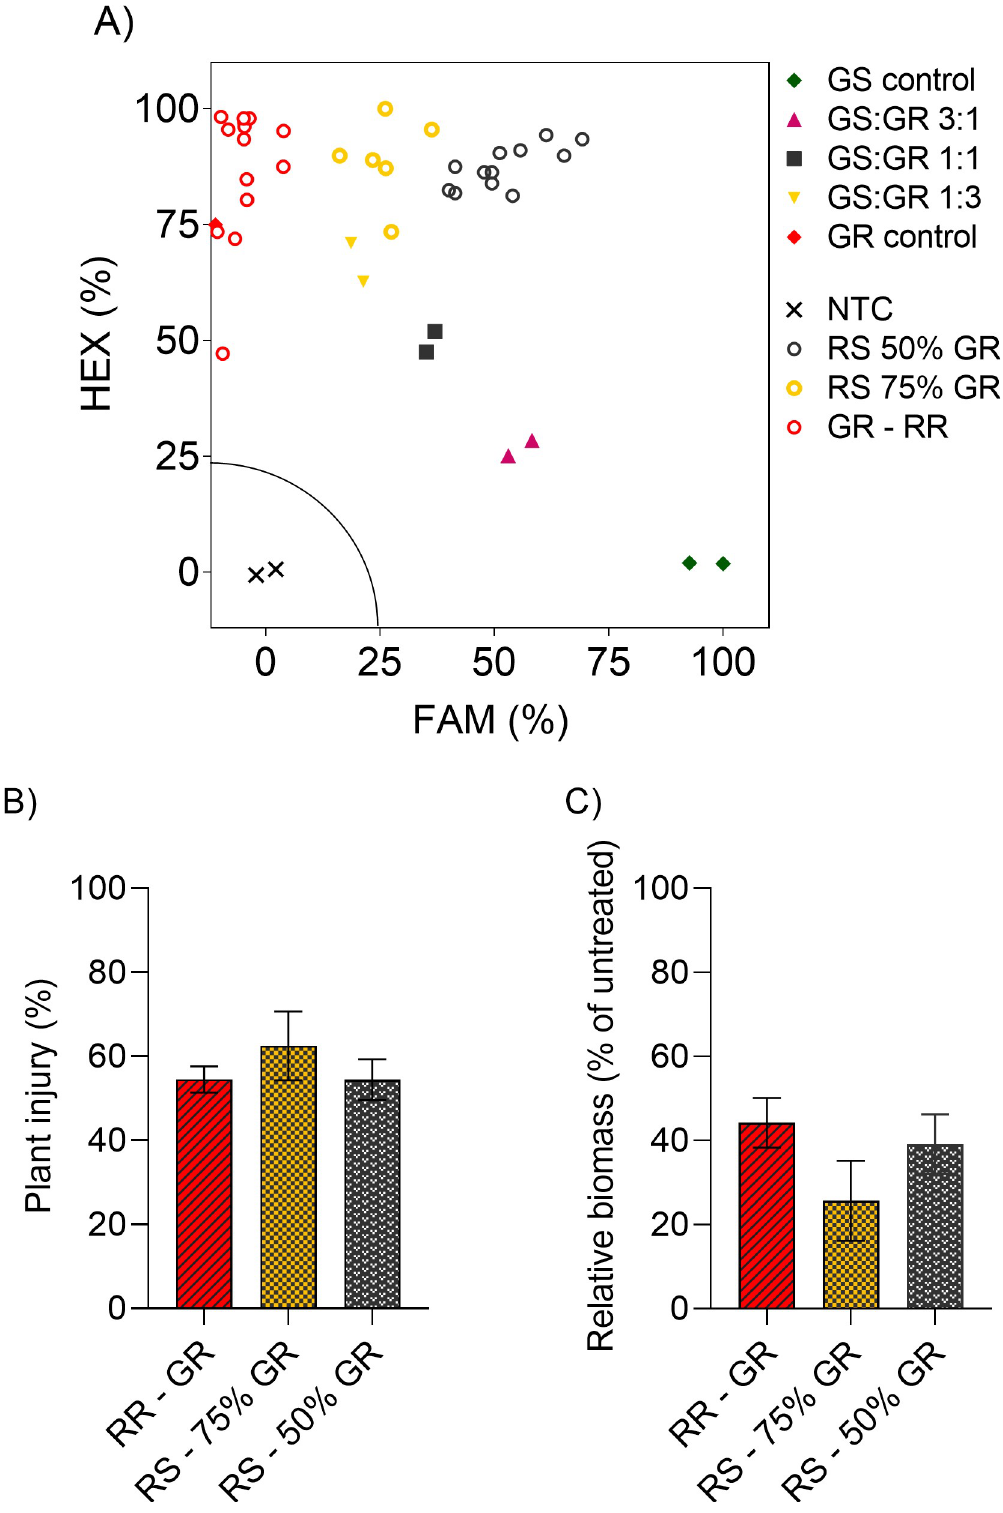
Fig 4. Proportion of homozygous (RR) and heterozygous (RS) individuals within the GR population and their correlation with plant response in glyphosate resistant (GR) wild poinsettia ( Euphorbia heterophylla ). (A) The KASP marker provided three groups of allele frequency based on the Pro106Thr mutation: Six heterozygous with 75% of mutant